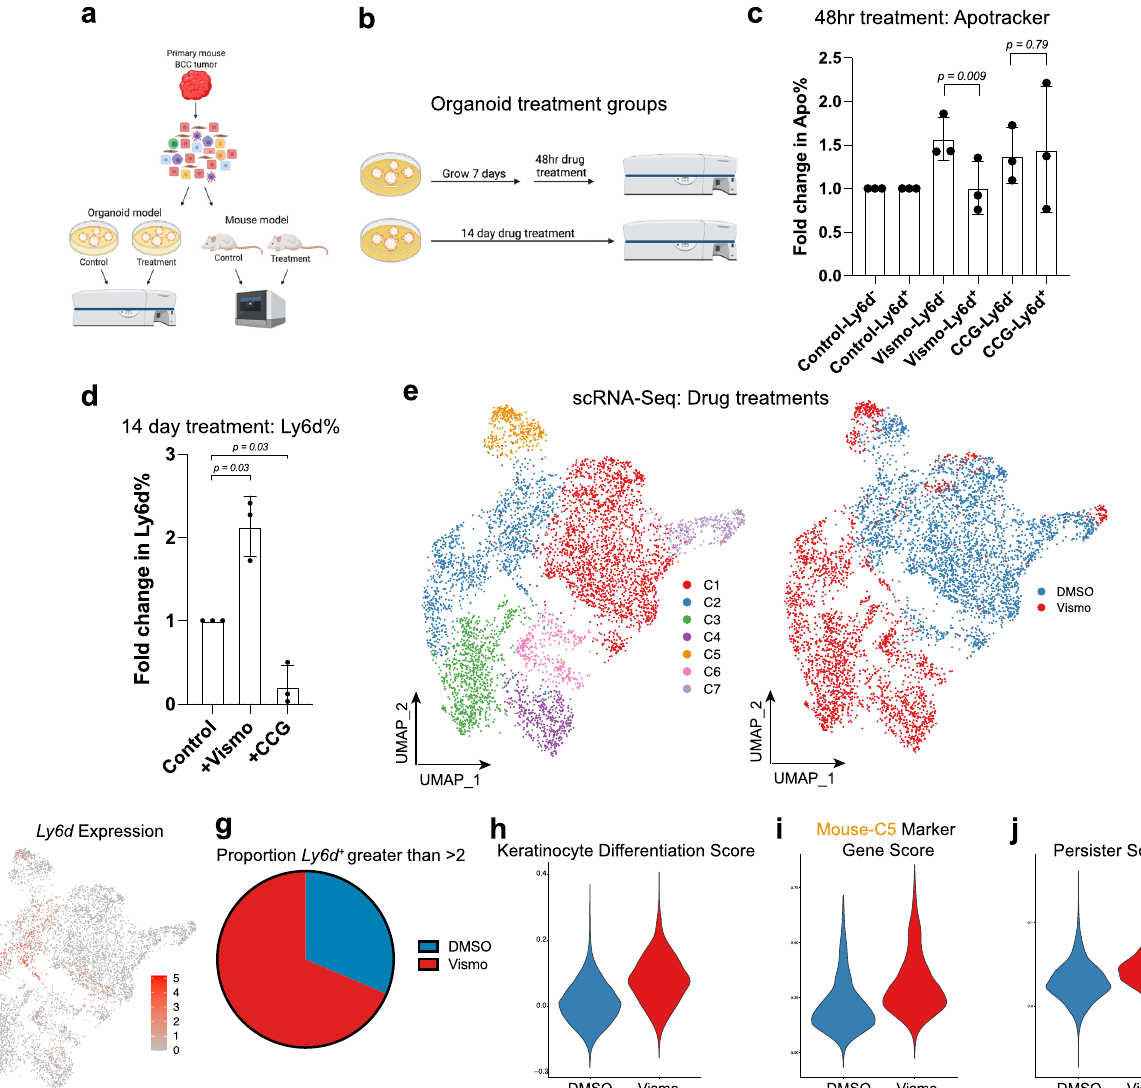
Fig. 5 | Drug treatments in fl uence LY6D + cellular accumulation. a Schematic diagram for tumor dissociation and subsequent experimentaldesigns with in vitro organoid or in vivo allograft drug treatments. b Schematic diagram of organoid treatments designed to examine acute and long-term drug treatments. c Fold change in Apotracker Green in organoids treated with either SMO i or CCG. Each point represents Apotracker Green% of Ly6d − or Ly6d + cells from distinct drug treated organoids derived from different primary tumors ( n =3). d Fold change in Ly6d%inorganoidstreatedwitheitherSMO i orCCG.Eachpointrepresentsthefold change in Ly6d% from distinct drug treated organoids derived from different